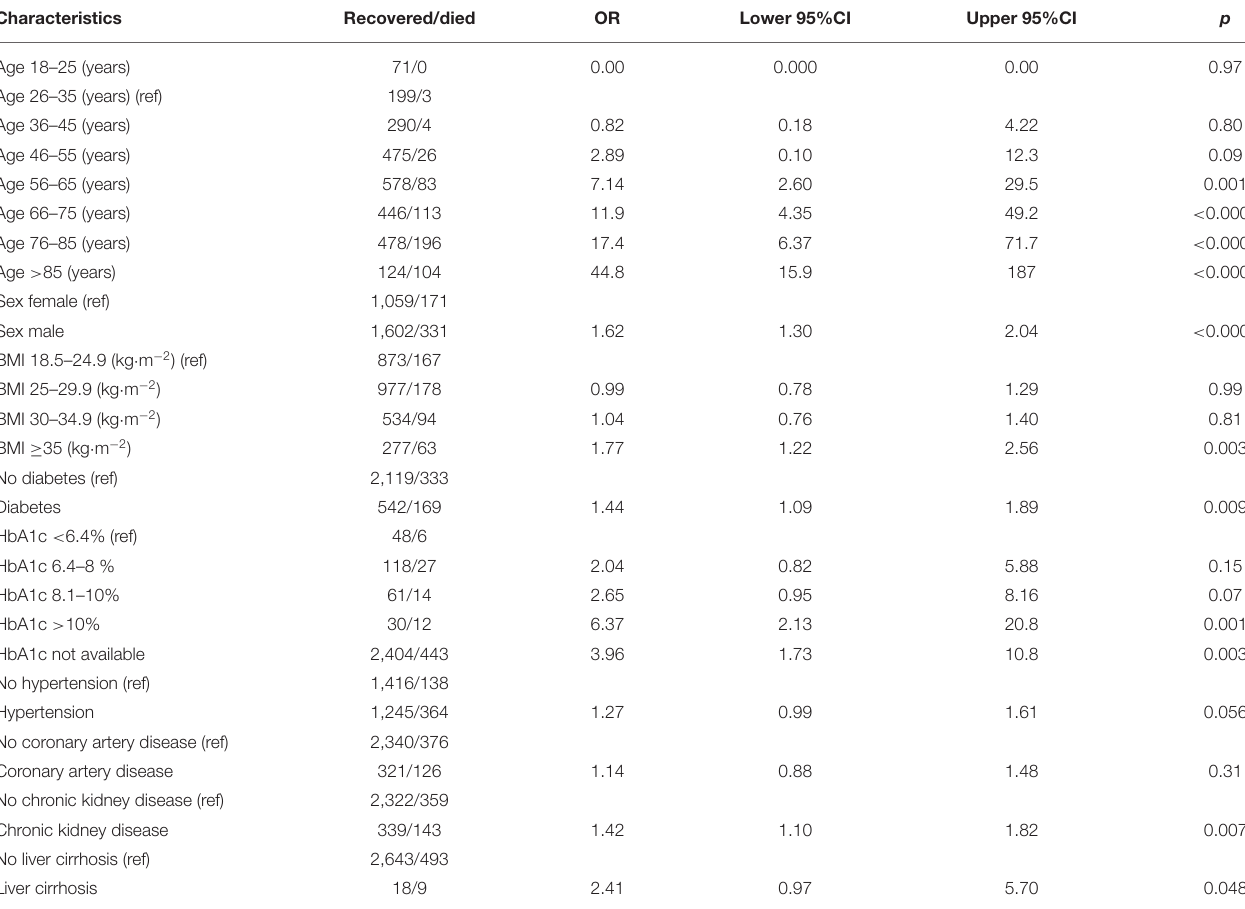
TABLE 1 | Multivariable relationships of selected anthropometrics, comorbidities and laboratory parameters with COVID-19-related mortality.